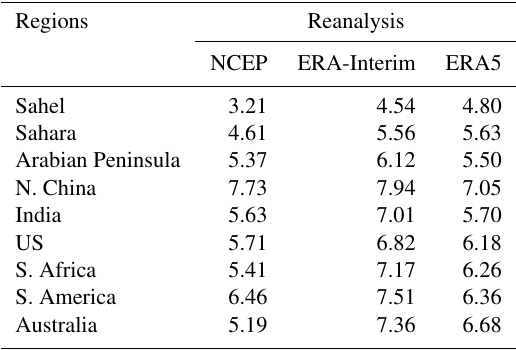
Table 3. Sensitivity of the annual mean wind erosion thresh- old (ms − 1 ) to surface wind speeds from different reanalyses (DOD thresh = 0 . 2 or